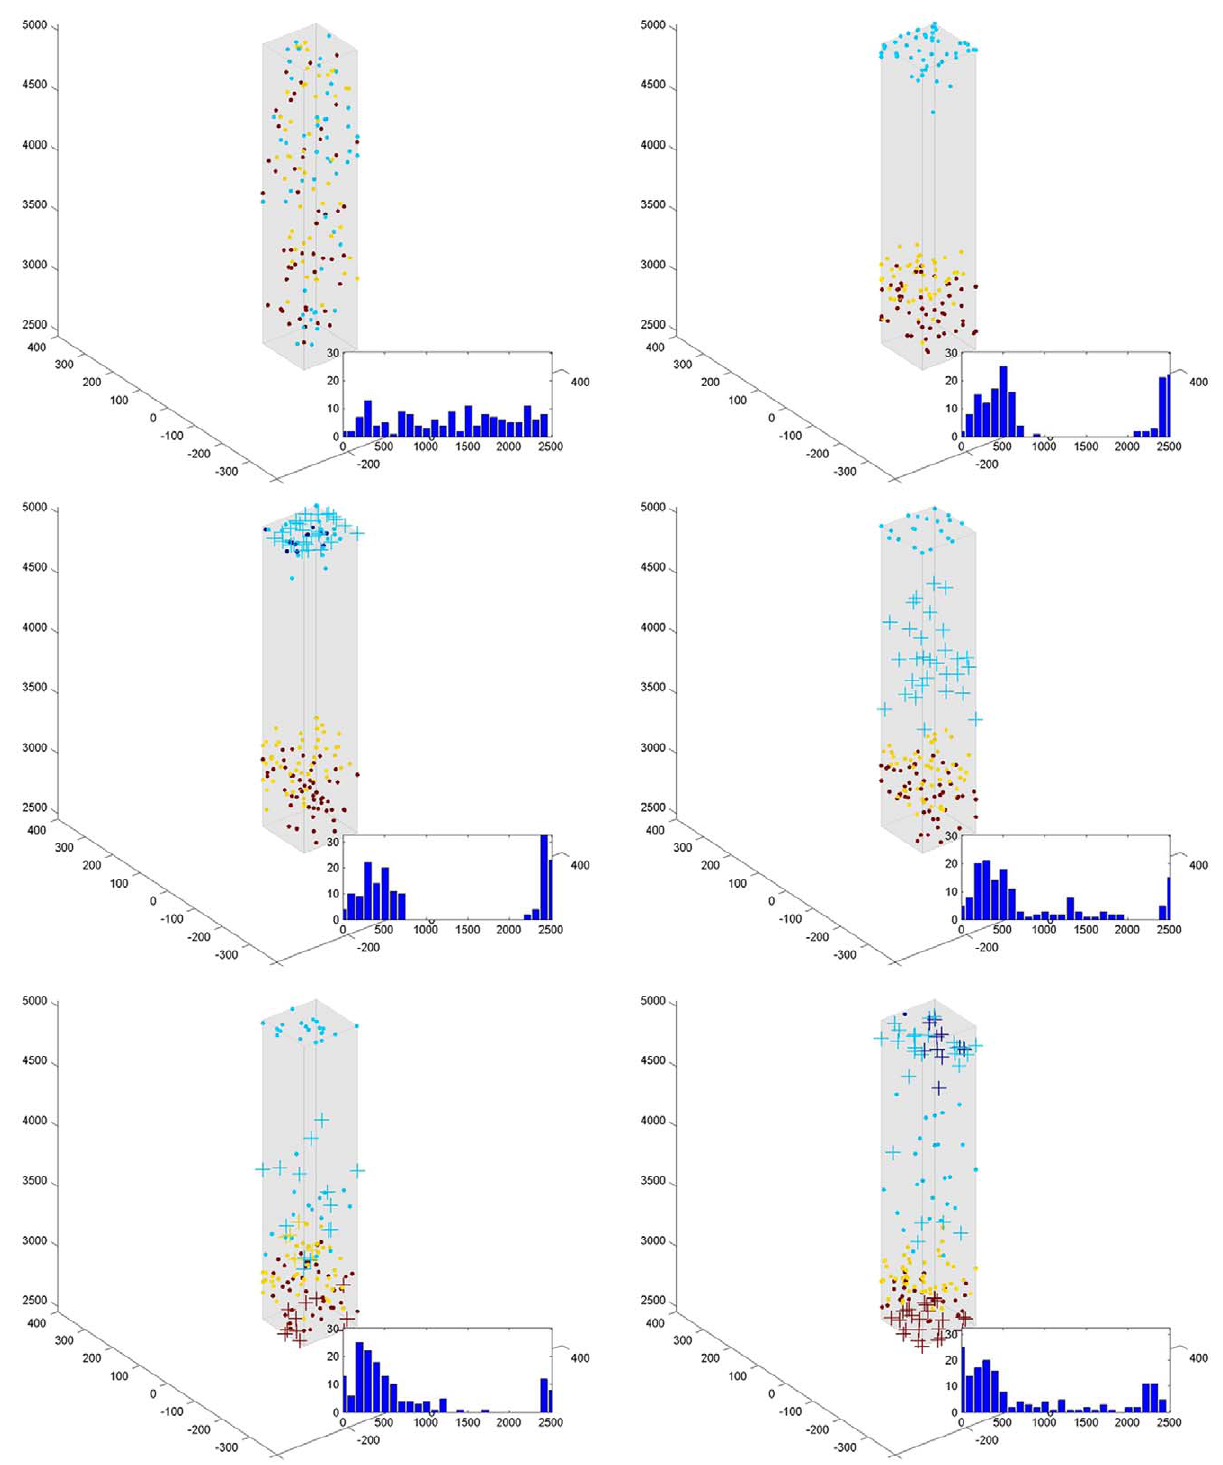
Figure 4. Dynamic modeling of RAF, MEK and ERK after ligand binding. In the initial state, RAF is clustered around the CM and MEK and ERK around the NM. When ligand binds the membrane receptor, RAF is phosphorylated. The negative chareges interact with the intracellular field resulting in rapid ( , 0.01 sec) movement of pRAF toward the NM. As it reaches the perinuclear region, pRAF encounters and phosphorylates several MEK proteins which, in turn, phosphorylate several ERK proteins. The rapid, direct movement of pRAF provides spatial and temporal information while the interactions with MEK and ERK amplify the signal at the NM. The pRAF is assumed to encounter a phosphorylase after about 30 seconds. The loss of negative charges causes RAF to return to it original isoelectric point with very rapid ( , 0.01 sec) return to the CM where it is again available for signal transduction.